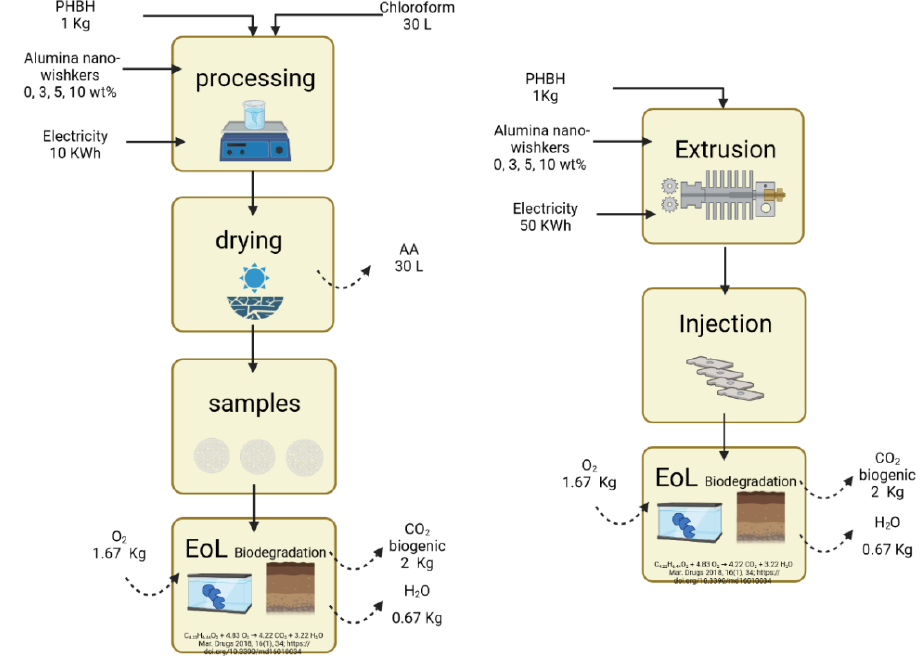
Figure 2. Flow diagrams used to carry out the inventory for PHBH nanocomposites.